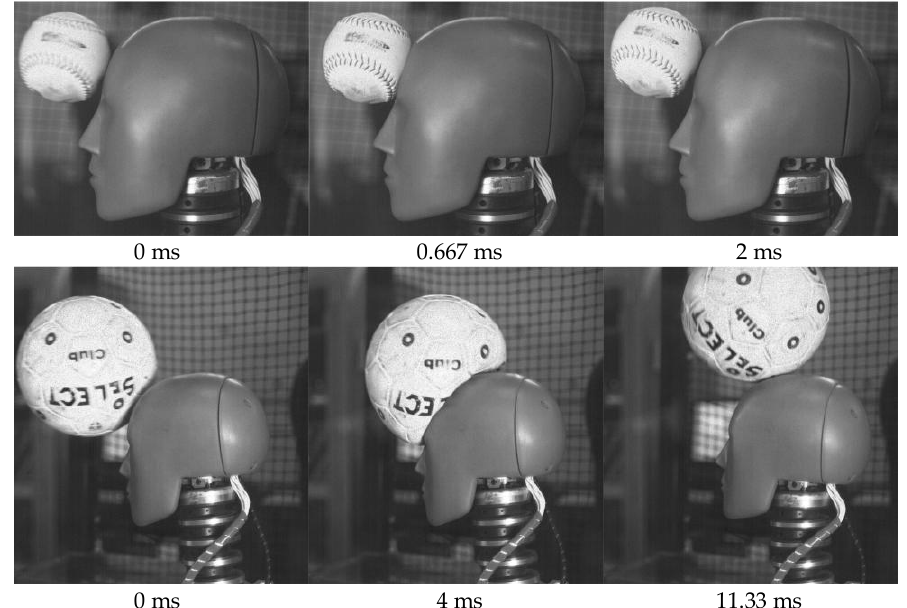
Figure 2. Estimated initial contact ( left ), maximal ball deformation ( middle ) and end of contact ( right ), for softball ( top ) and soccer ball ( bottom ) impacts.